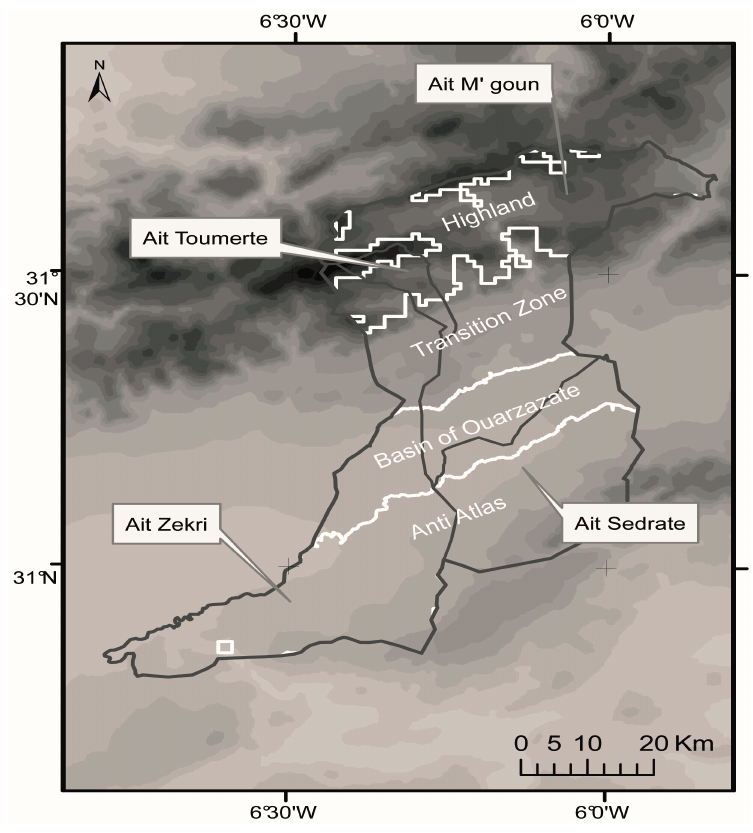
Figure 3. Migration of transhumant herds in our LDM is possible between four pastures (white lines). Territories of four kin groups are considered (grey